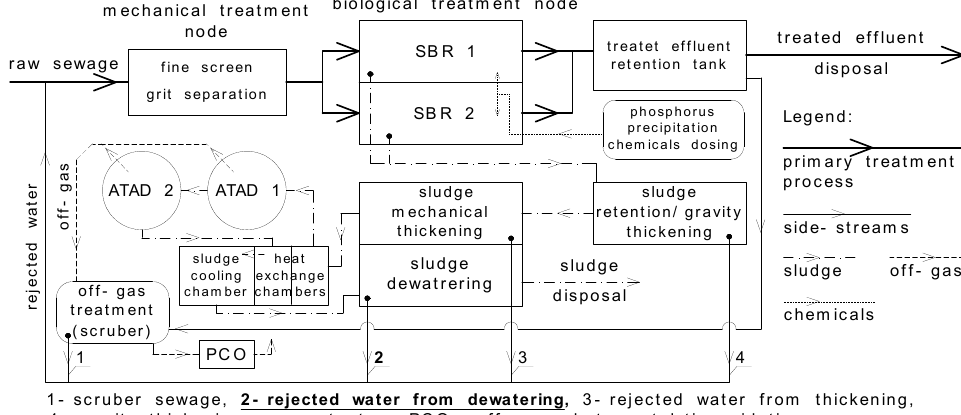
Figure 3. Simplified process flow diagram of WWTP3.